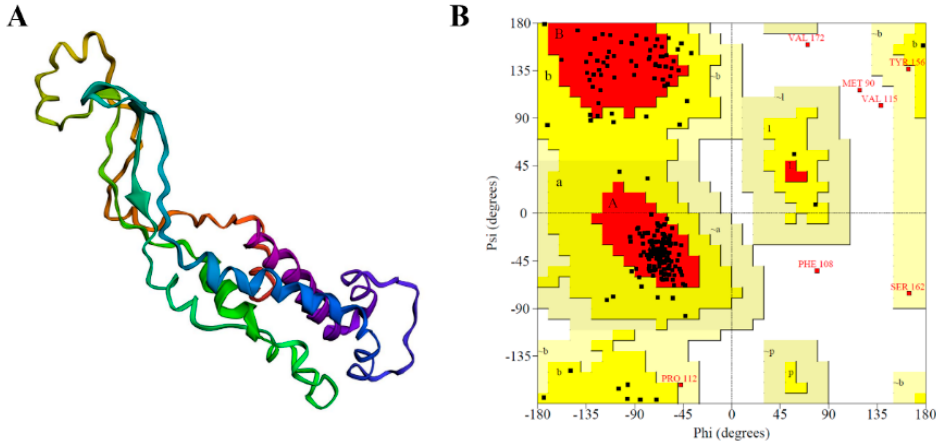
Figure 3. β -casein model ( A ) and its Ramachandran plot ( B